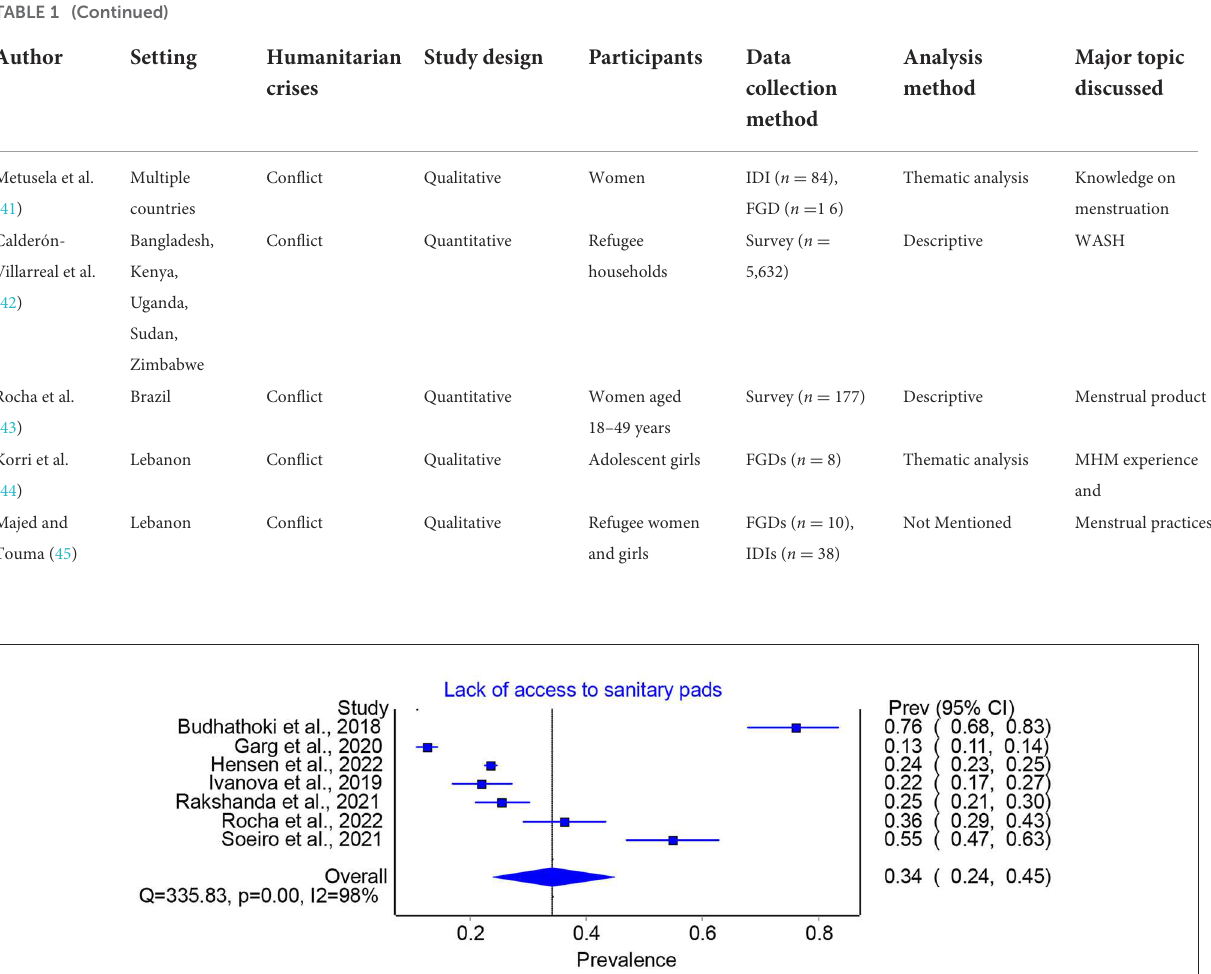
FIGURE2 Prevalence of lack of access to sanitary pads in humanitarian crises.